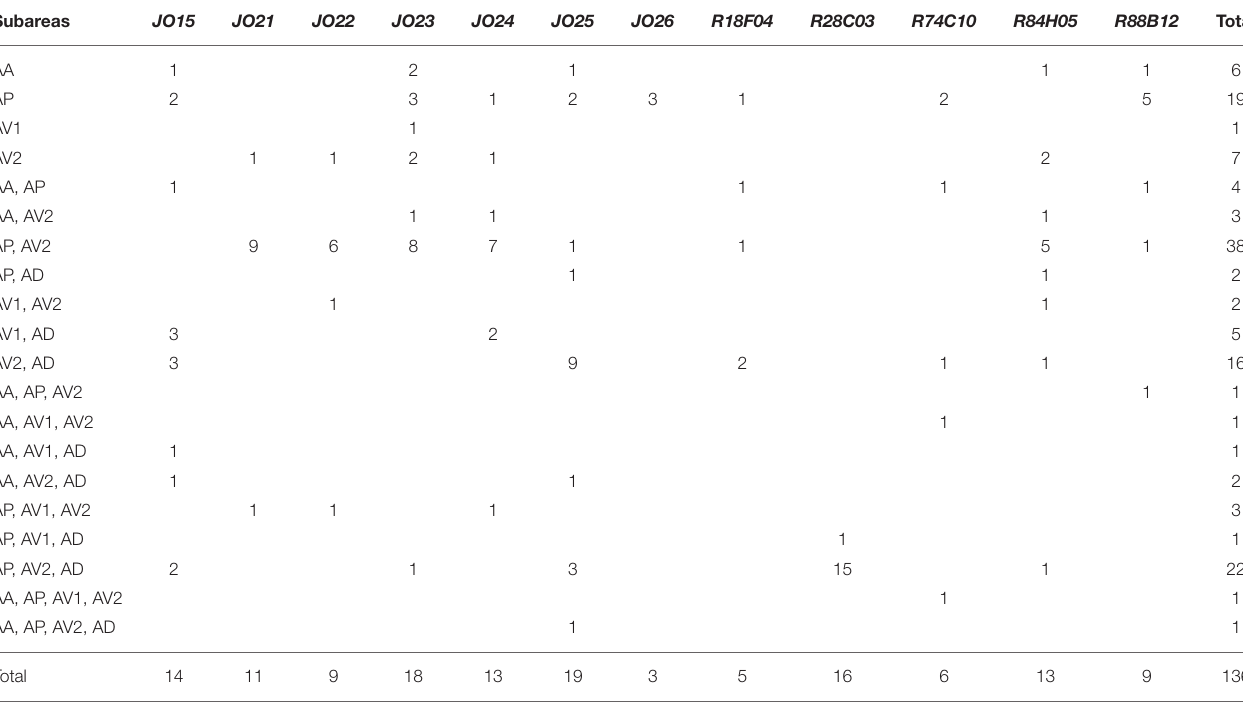
TABLE 3 | Single subgroup-A neurons obtained in each JO-A strain. Subareas JO15 JO21 JO22 JO23 JO24 JO25